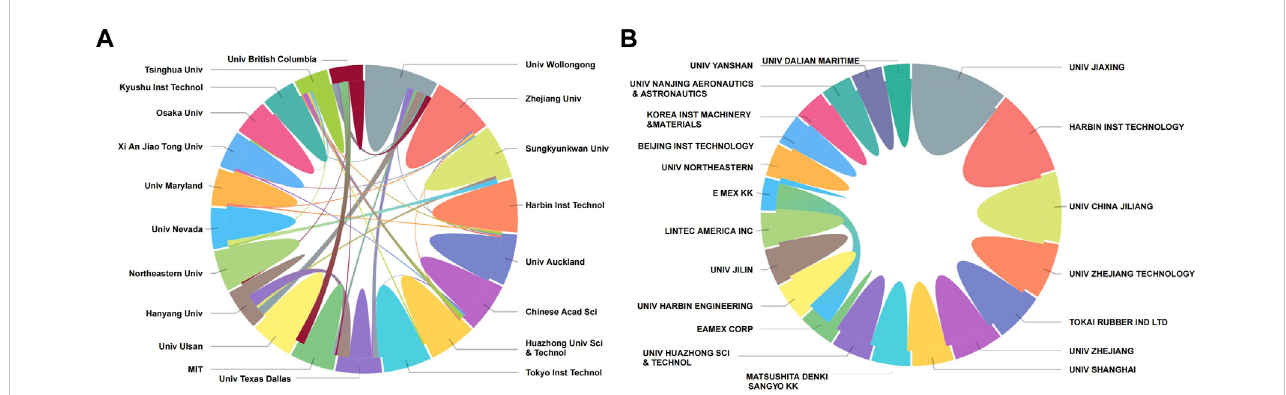
FIGURE 2 Pie map on productions and collaborations of the top 20 most productive institutions in arti fi cial muscles (A) the top 20 productive institutions from a paper perspective; (B) the top 20 productive institutions from a patent